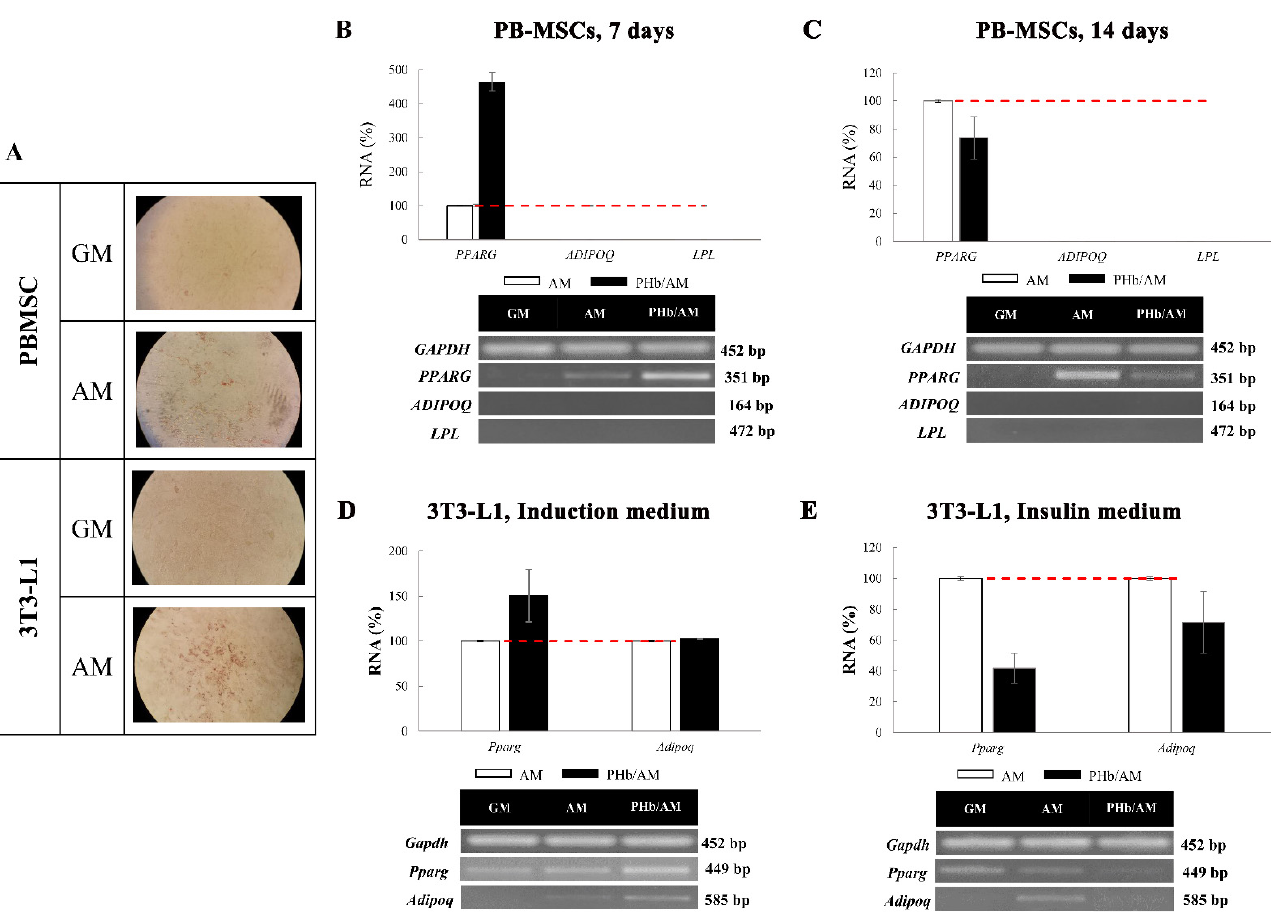
Figure 7. Acellular porcine hemoglobin (PHb) reduces adipogenic differentiation capacity of mes- enchymal cells. The adipogenic differentiation was confirmed by Oil Red staining of lipid droplets in PB-MSCs cultured for 28 days and 3T3-L1 cultured for 10 days in adipogenic medium (AM) ( A ). Adipogenic differentiation of PB-MSCs was confirmed by RT-PCR of analysis of expression of PPARG , ADIPOQ , and LPL genes. PB-MSCs were cultivated in adipogenic medium (AM) supplemented with or without 0.1 µM PHb for 7 days ( B ) and 14 days ( C ). Adipogenic differentiation of 3T3-L1 was confirmed by RT-PCR of analysis of Pparg and Adipoq genes. PHb was added starting from induction medium ( D ) or insulin medium ( E ). GAPDH was used as a gel loading control. Representative RT-PCR bands are shown. The RT-PCR results are expressed as relative to corre- sponding control (AM, set as 100%). Mean ± SD of three independent experiments is shown.